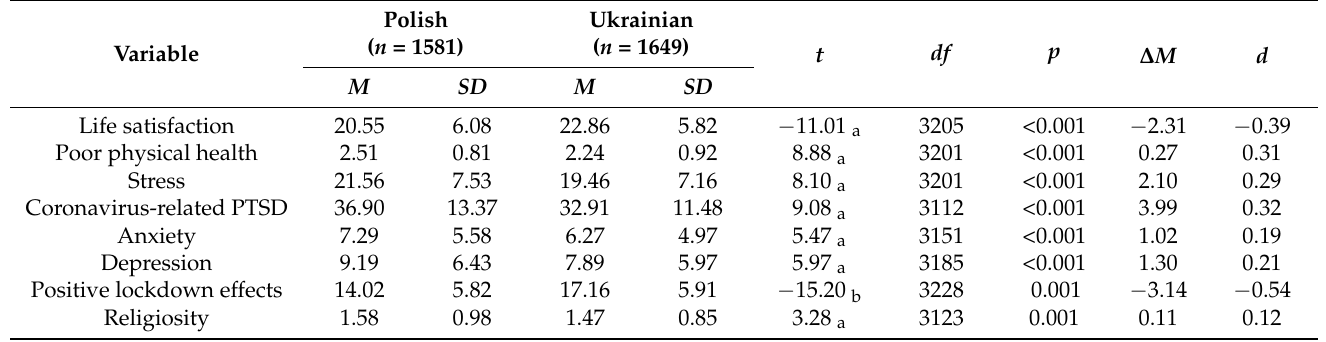
Table 3. A comparison of Ukrainian and Polish samples in mental and physical health.